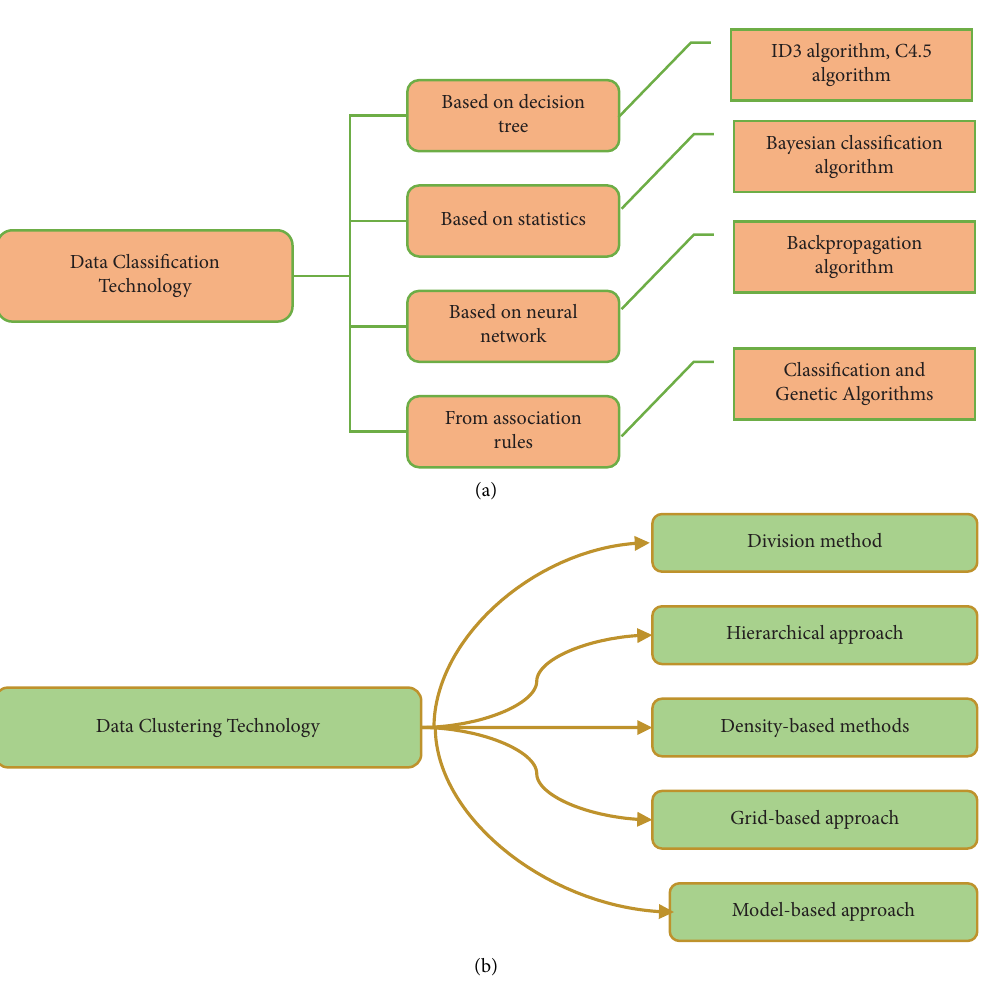
Figure 7: (a) Data classifcation algorithm and (b) data clustering